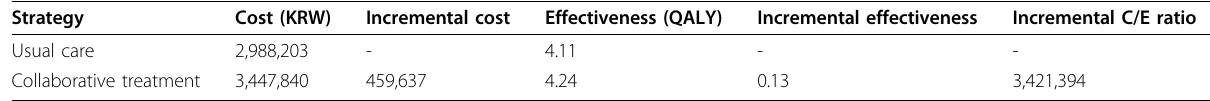
Table 6 Deterministic analysis results (KRW in 2009) Strategy